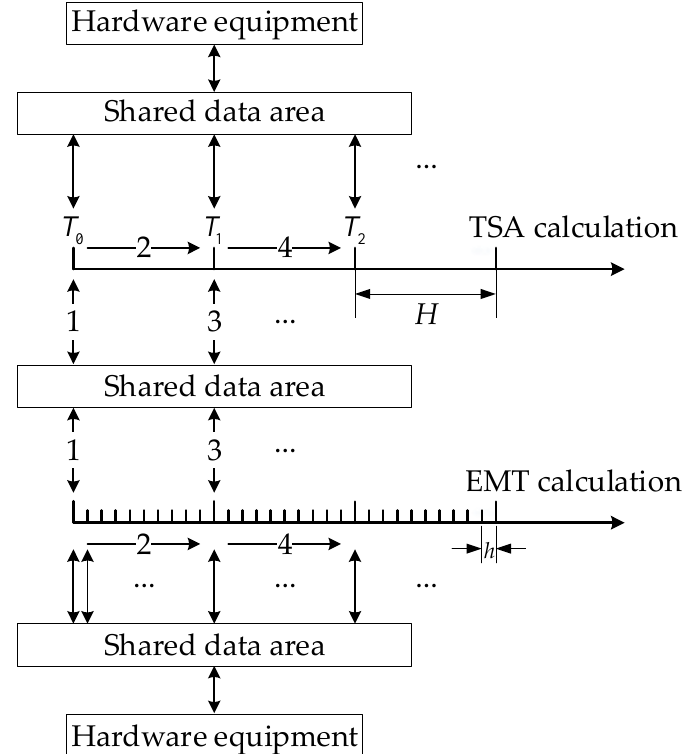
Figure 1. The overall protocol for a hybrid real-time simulation system interaction. TSA: transient stability analysis; EMT: electromagnetic transient.